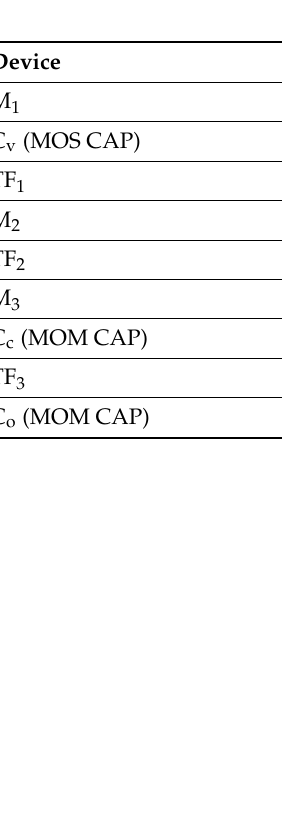
Table 1. Circuit component parameters of the two VCOs.